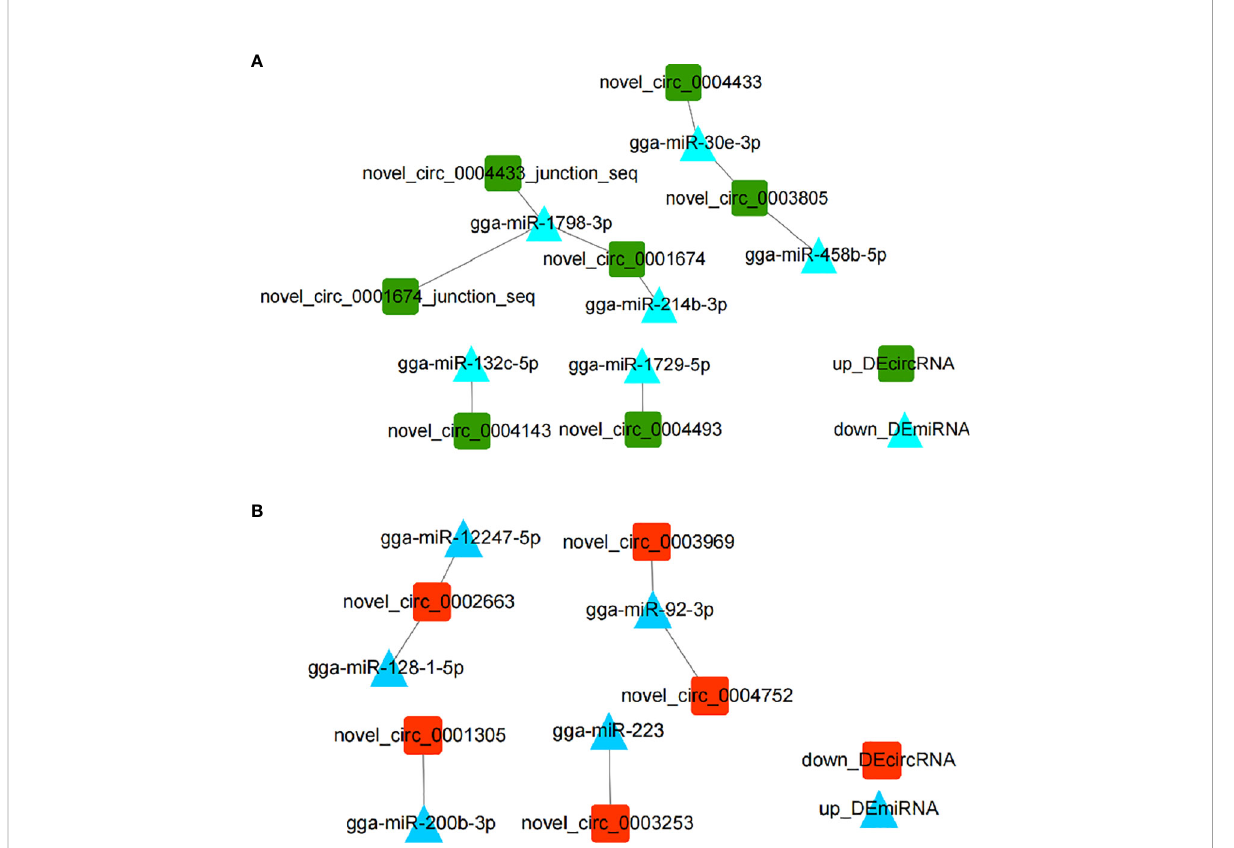
FIGURE 2 Interaction networks of DEcircRNA - DEmiRNA pairs involved in the immune response to E. tenella infection with threshold parameters (single- residue-pair match scores> 140, D G< -10 kcal/mol). (A) Networks of up _ DEcircRNA - down _ DEmiRNA generated using Cytoscape 3.7.2. (B) Networks of down _ DEcircRNA - up _ DEmiRNA generated using Cytoscape